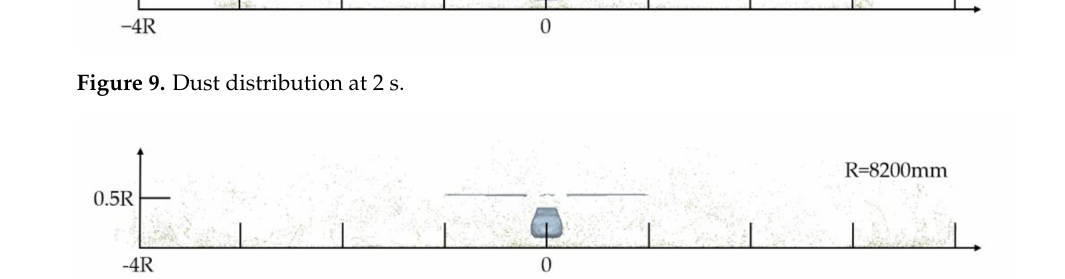
Figure 10. Dust distribution at 3